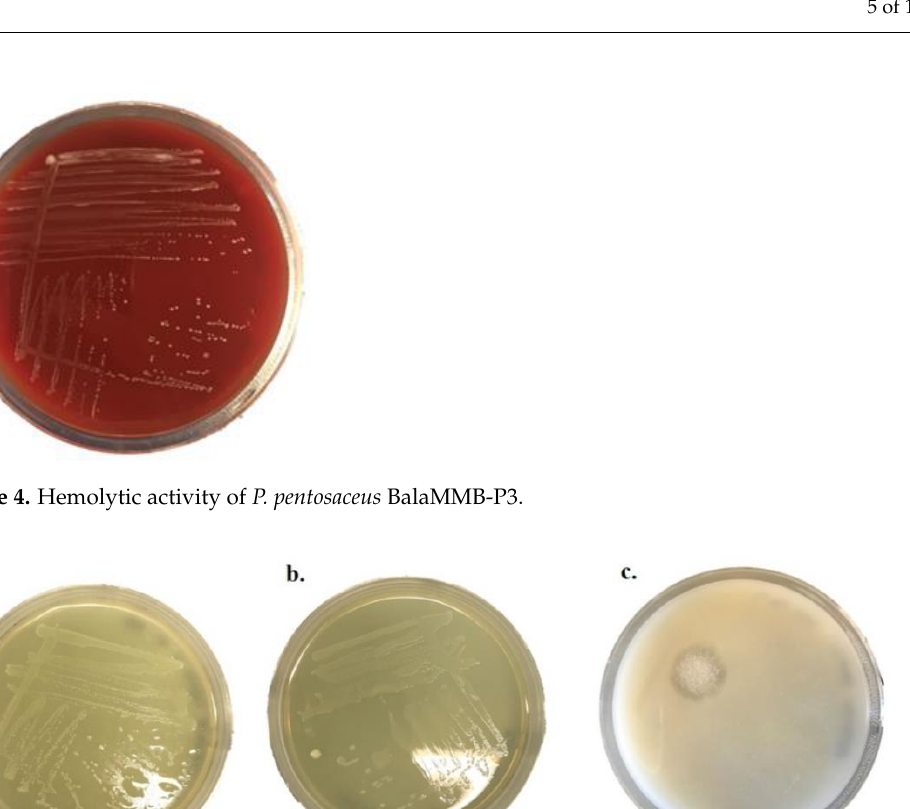
Figure 5. Enzymatic activities of P. pentosaceus in lipase agar ( a ), amylase agar ( b ) and protease agar ( c ).